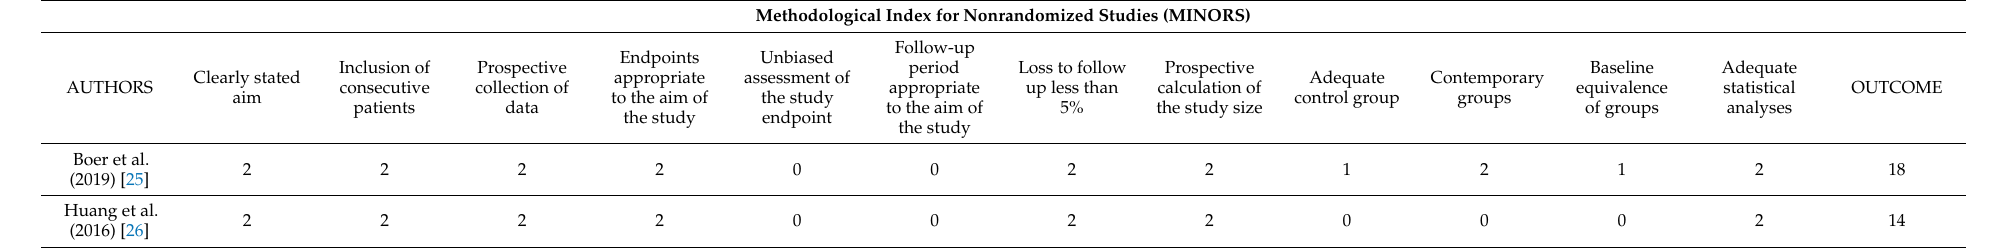
Table 3. Methodological index for nonrandomized studies (MINORS) to assess the methodological quality and risk of bias of the observational included studies. The items are scored 0 (not reported), 1 (reported but inadequate) or 2 (reported and adequate). The global ideal score being 16 for noncomparative studies and 24 for comparative studies. Methodological Index for Nonrandomized Studies